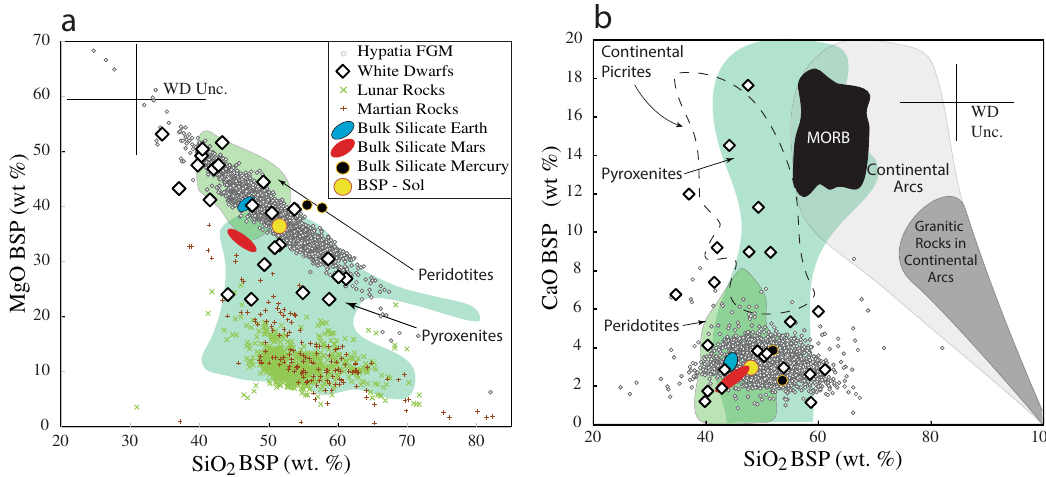
Fig. 2 A comparison of planetary bulk silicate (mantle + crust) compositions. Bulk silicate planet (BSP) compositions of polluted white dwarfs (PWDs) are compared to bulk silicate compositions of the inner planets 20 – 22, 24 – 27 and the BSPs inferred from Hypatia stars 17 , as well as a mantle rocks from Earth 21 (peridotites and pyroxenites) and b crustal rocks from Earth 31 , Moon 32 , and Mars. MgO + SiO 2 + CaO + FeO are normalized to 100%. BSPs are PWDs when metallic cores are removed from the bulk PWDs of Fig. 1, to allow comparison to silicate compositions of the inner planets. “ WD Unc. ” indicates the propagated average uncertainty of PWD compositions. b shows that Earth ’ s continental rocks are a poor match for PWD silicate fractions. a and b show that rocks from Earth ’ s mantle are a good match for PWDs. But only one PWD matches bulk silicate Earth; most PWDs match rock types that are not dominant on any inner planet. Sol Solar, MORB Mid-Ocean Ridge